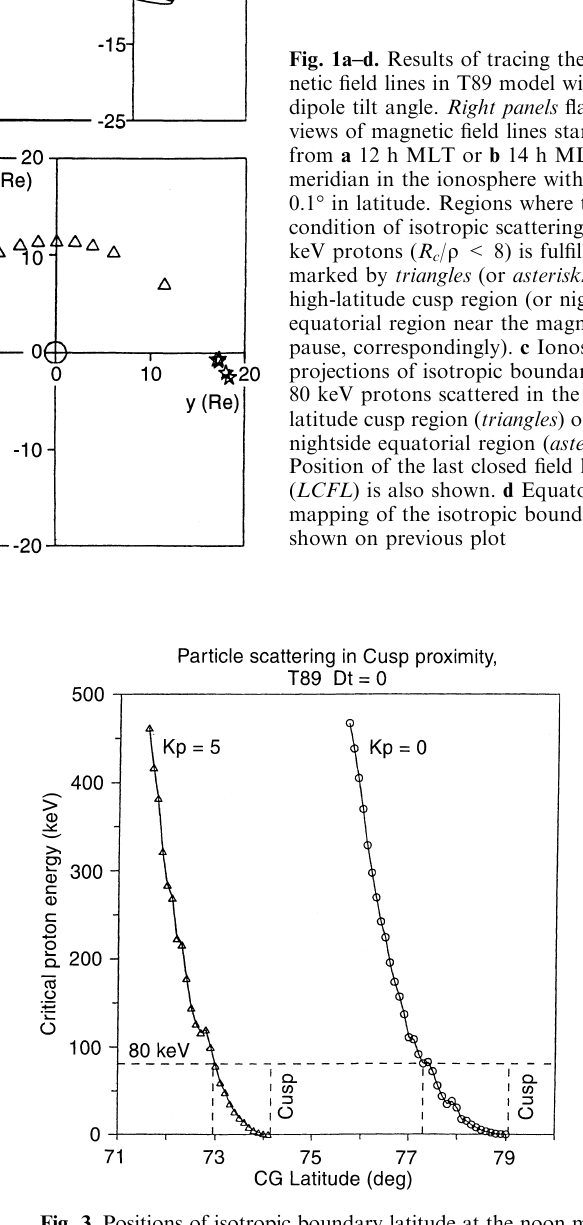
in T89 model for protons of di(cid:128)erent energy characterizing the expected energy dispersion of magnetic field magnitude (see Fig. 2). Moving away from noon in magnetic local time (14 h MLT in Fig. 1b), the outermost closed field line stays approxi-